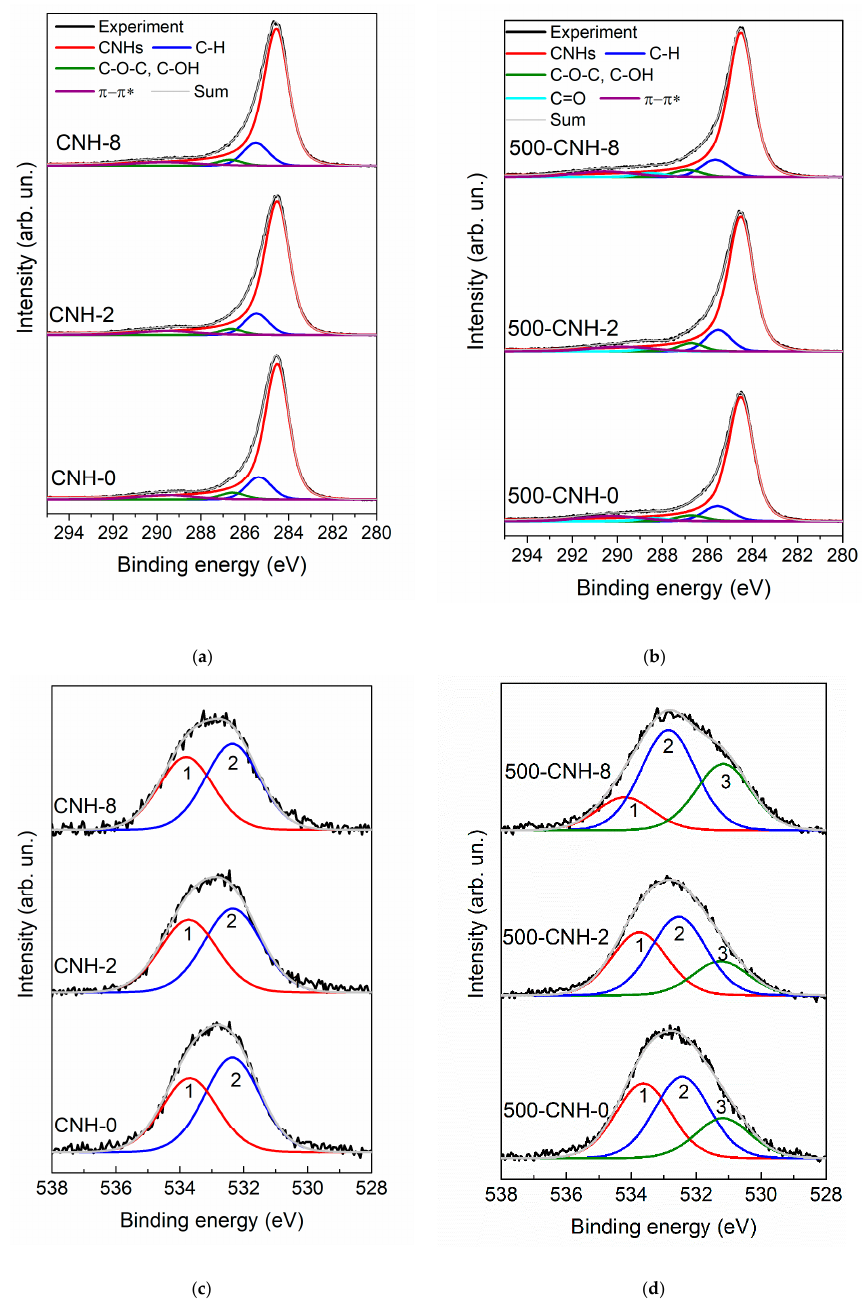
Figure 7. XPS C 1s ( a , b ) and O 1s ( c , d )spectra of initial CNHs ( a , c ) and those thermally oxidized at 500 °C ( b , d ).